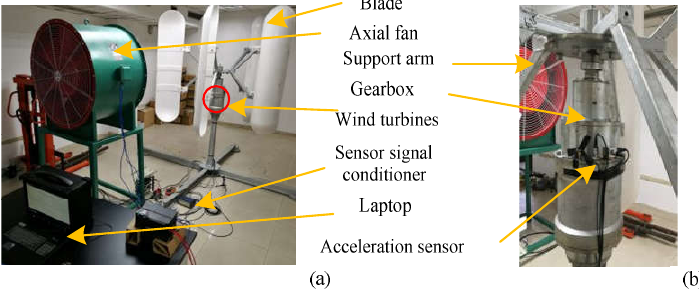
Figure 2. Wind turbine experimental setup: ( a ) components and architecture of the experimental setup; ( b ) position of the sensors.